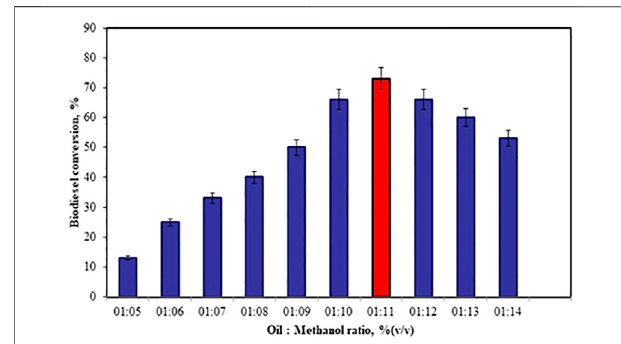
FIGURE 3 | SEM analysis of zinc doped iron nanocatalyst. FIGURE 4 | Effect of oil to methanol molar ratio on biodiesel